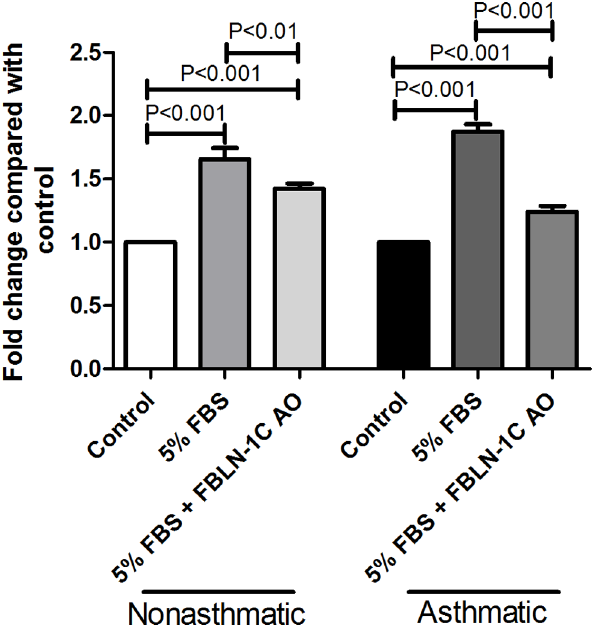
Figure 10. FBLN-1C promotes proliferation of ASM cells. FBLN- 1C in the ECM deposited by an asthmatic ASM cell line was inhibited by a FBLN-1C specific AO. ASM cells from non-asthmatic (n=4) or asthmatic (n=4–5) volunteers were reseeded on the ECM and the effect on cell proliferation in response to 5% FBS was determined. Data are expressed as mean 6 SEM.